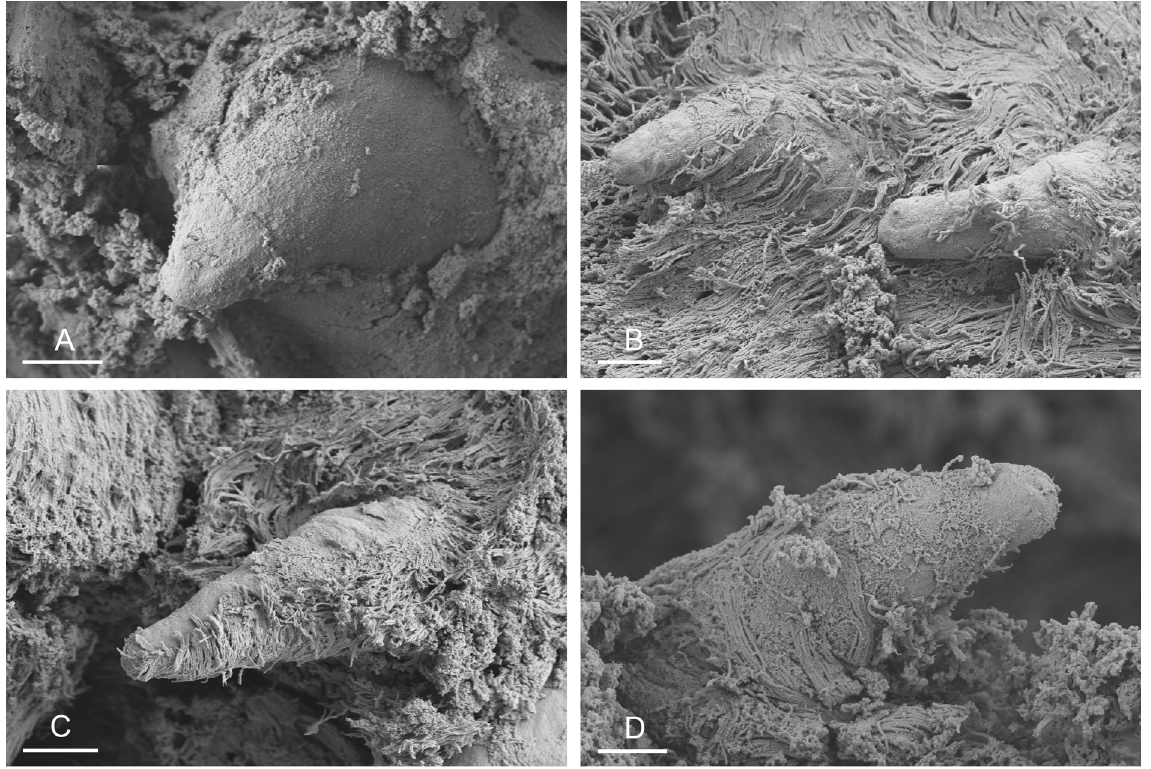
Fig. 23. Paromoionchis tumidus (Semper, 1880) comb. nov. unit #3, penial hooks, Papua New